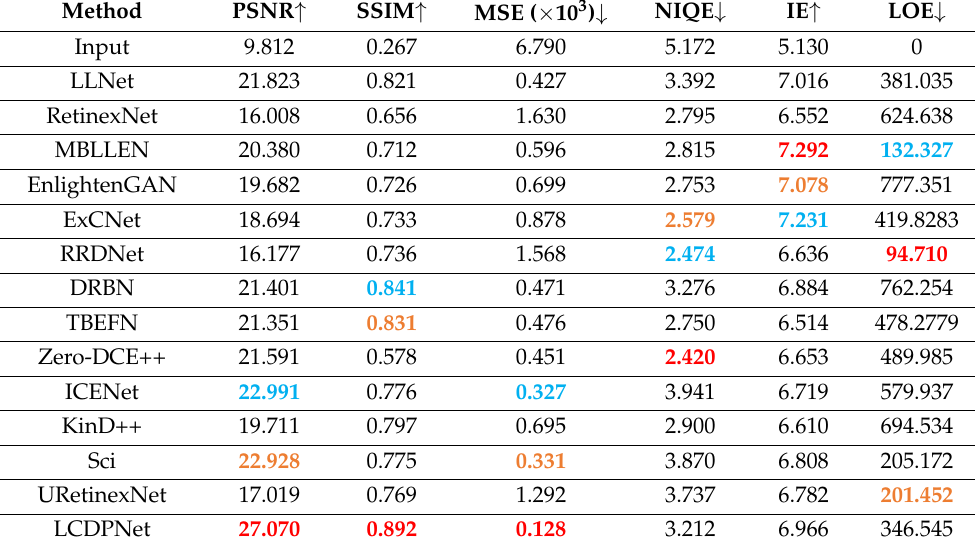
Table 7. Quantitative comparison of the VE-LOL-L dataset (Paired Dataset) according to PSNR, SSIM, MSE, NIQE, IE, and LOE. The best result is bold in red , the second result is bold in blue , and the third result is bold in yellow